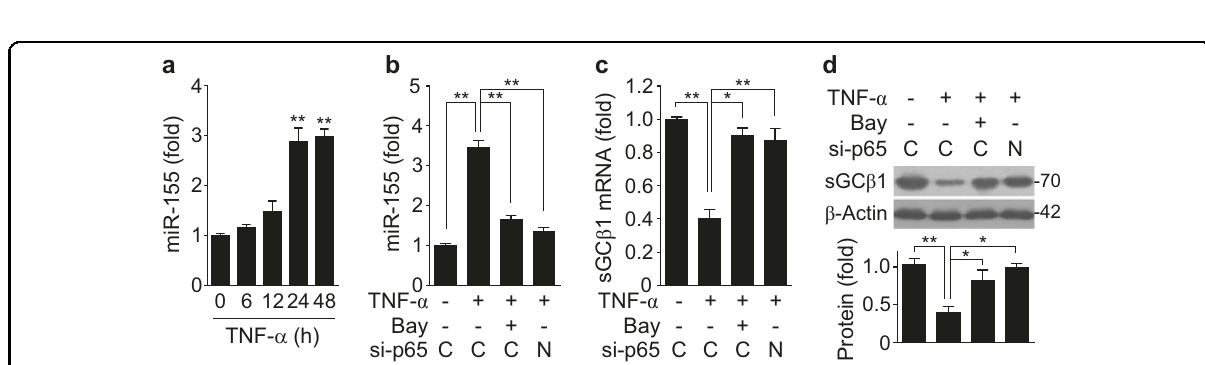
Fig. 2 MiR-155 and sGC β 1 are differentially expressed in HFD-fed ApoE − / − mice and atherosclerotic and preeclamptic patients. a The miR- 155 levels in sera from atherosclerotic patients and healthy controls were assessed by qRT-PCR ( n = 11 per group). b , c The levels of miR-155 and sGC β 1 protein were determined in aortic vessels of ApoE − / − mice fed a HFD or a chow diet by qRT-PCR and Western blotting ( n = 6 per group). d The miR-155 levels in sera and placental vessels from healthy pregnant (HP) women and preeclamptic patients (PE) were determined ( n = 10 per group). e The sGC α 1 and sGC β 1 mRNA levels in placental vessels from healthy pregnant women and preeclamptic patients were analyzed by RT-PCR ( n = 10 per group). ** P <